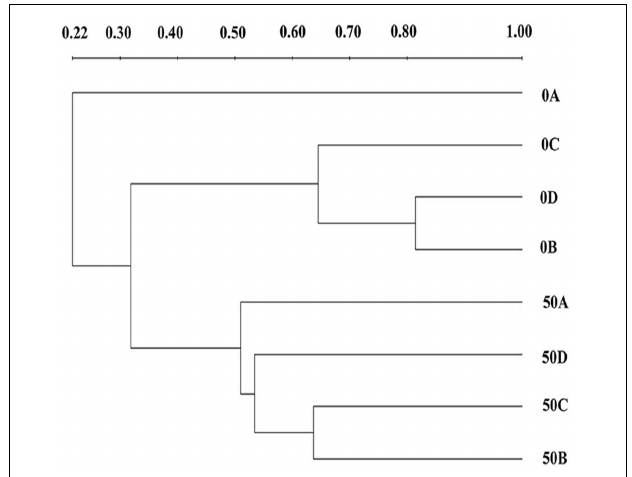
FIGURE 5 | Phenol biodegradation by the five isolates designated as DW-1, DW-2, DW-3, DW-4, and DW-5. Cultures were incubated in 80 mL of MSM supplemented with 500 µ g/L of phenol at 30 ◦ C at 120 rpm. No phenol degradation occurred in the autoclaved control bottles. The mean values from triplicate experiments and the standard errors of the means, indicated by error bars, are